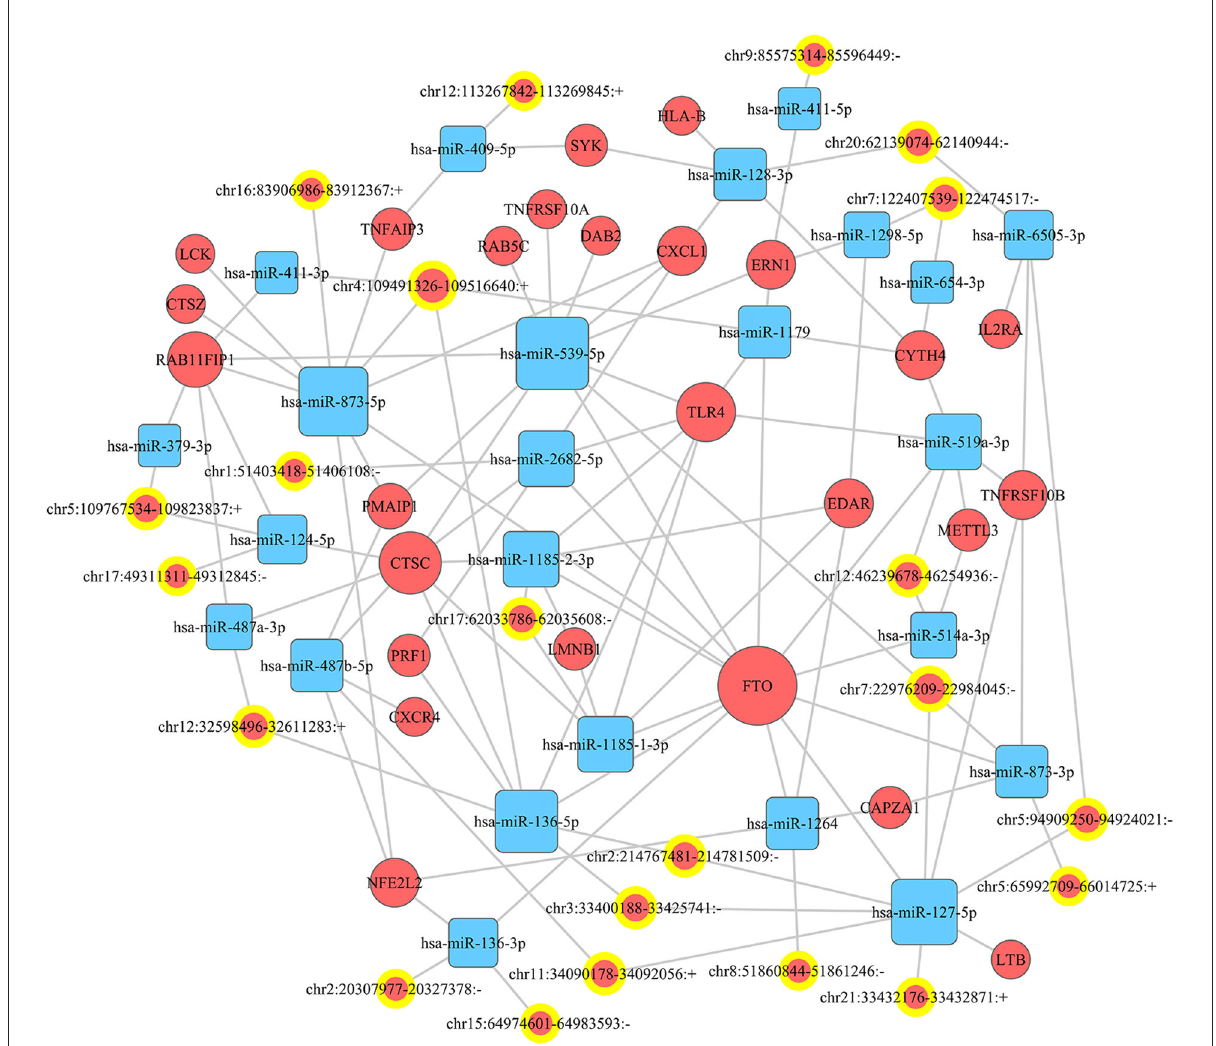
FIGURE3 CeRNA network. A ceRNA (circRNA-miRNA-mRNA) network was established to show the relationship among circRNA, miRNA, and